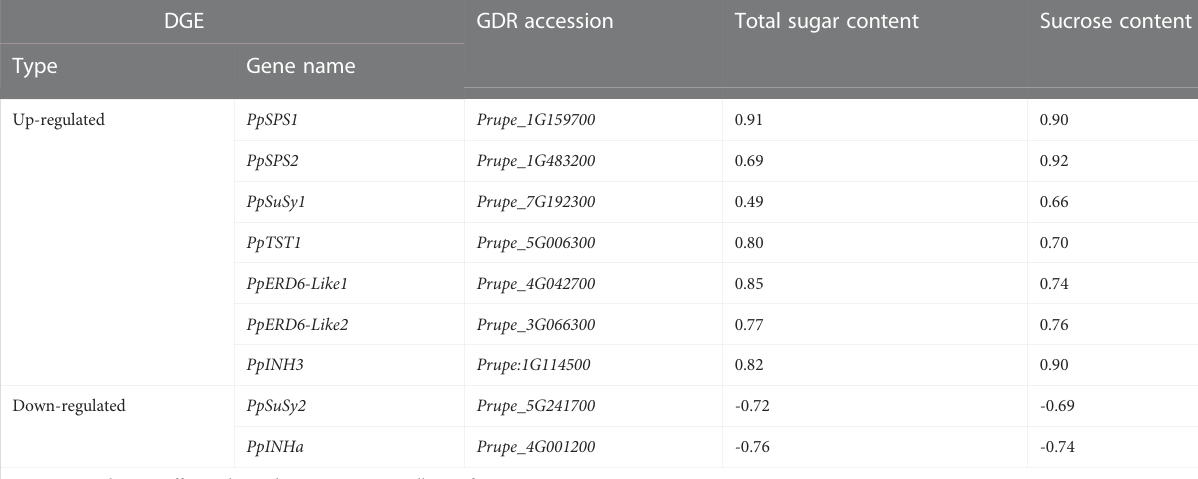
BA FIGURE 2 Identi fi cation of DEGs associated with total sugar content in peach fruits between different genotypes or developmental stages. (A) , Venn diagrams showing the numbers of DEGs up-regulated in cultivated fruits at the S3 stage relative to wild fruits (left), up-regulated in cultivated fruits at the S3 stage relative to the S2 stages (middle), the intersection of the commonly up-regulated genes across cultivars and the commonly up-regulated genes across the developmental stages (right). (B) , Venn diagrams showing the numbers of DEGs down-regulated in cultivated fruits at the S3 stage relative to wild fruits (left), down-regulated in cultivated fruits at the S3 stage relative to the S2 stages (middle), the intersection of the commonly down-regulated genes across cultivars and the commonly down-regulated gene across the developmental stages TABLE 2 Pearson correlation coef fi cients between gene expression and sugar content*. DGE GDR accession Total sugar content Sucrose content